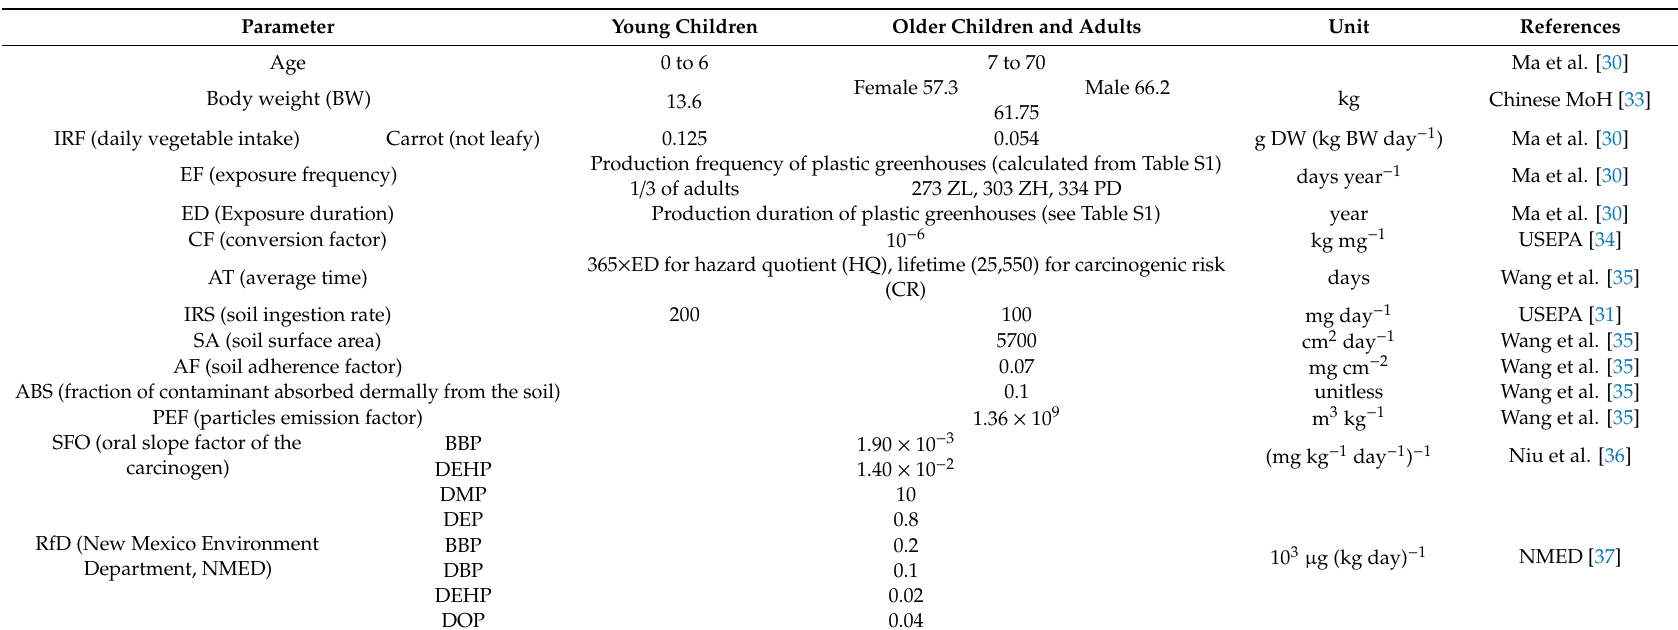
Table 1. Parameters for calculation of health risk